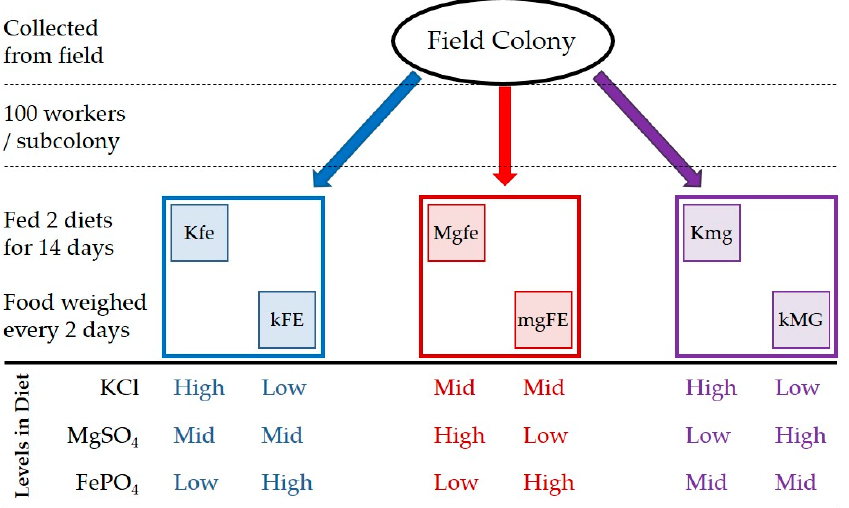
Figure 1. Setup of the experiment. The top portion outlines the experimental procedure for each of the ten colonies used in the experiment. Large boxes represent a subcolony and small boxes represent diets fed to the subcolonies. Each subcolony received two diets simultaneously. The lower portion of the figure indicates the relative levels of KCl, MgSO 4 , and FePO 4 in each diet.